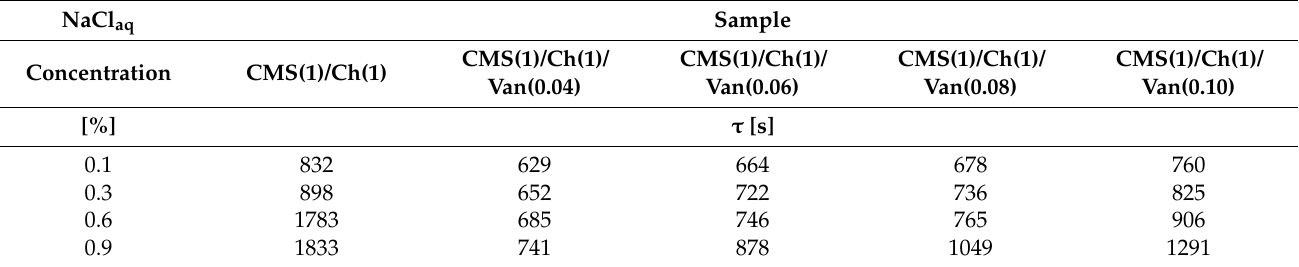
Table 4. Rate parameter in various concentrations of NaCl solution.